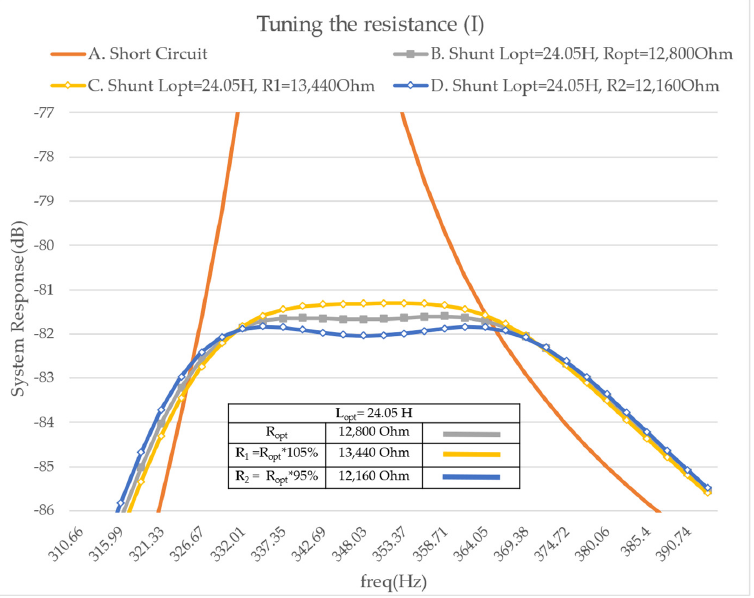
Figure 7. FRF Modulus on mode 2 — tuning the resistance — A. with a short circuit, B. with the optimal resistance, C. with twice the optimal resistance, D. with half of the optimal resistance.